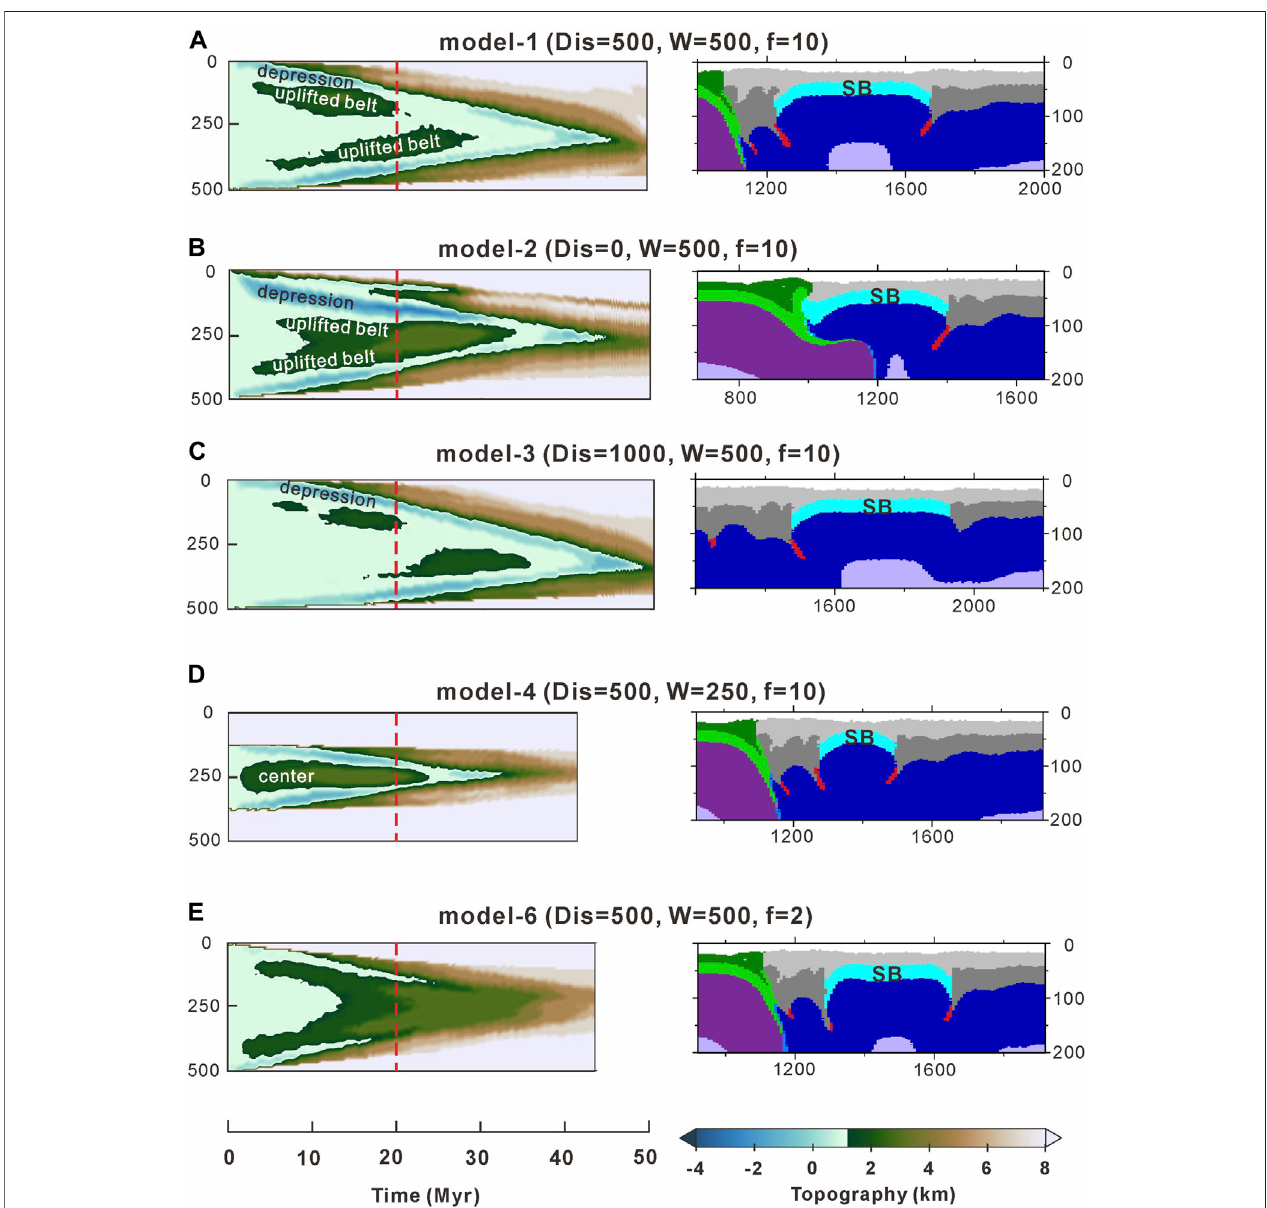
FIGURE 12 | Topographic features of the lowlands and deep structures in (A) model-1 (B) model-2 (C) model-3 (D) model-4, and (E) model-6. The left column exhibits the detailed topographic features of the lowland in different models. Red dashed lines highlight the time snapshot of 20 Myr. The right column shows the deep structures along section x = 2,000 km at the snapshot of 20 Myr. SB represents the strong basement of the basins. Depressions formed at the edges and uplifted belts formed adjacently due to bending of the strong lower crust. Note that a vertical exaggeration of two is used in the cross-sections of the right column.